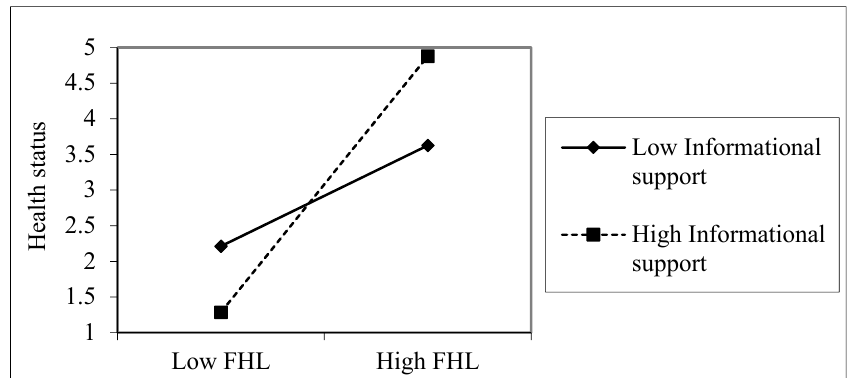
Figure 3. The association between informational support, FHL, and health status, the overall sample. Health status was measured on a five-point scale (poor, fair, good, very good, and excellent). The values used in the plotting are based on the unstandardized regression coefficients. 4. Discussion The study investigated whether various kinds of social support moderate the relations between FHL and health status among younger (and emerging) and older adults in Ghana. To the best of my knowledge, this is the first study to explore the moderating influence of social support on FHL and